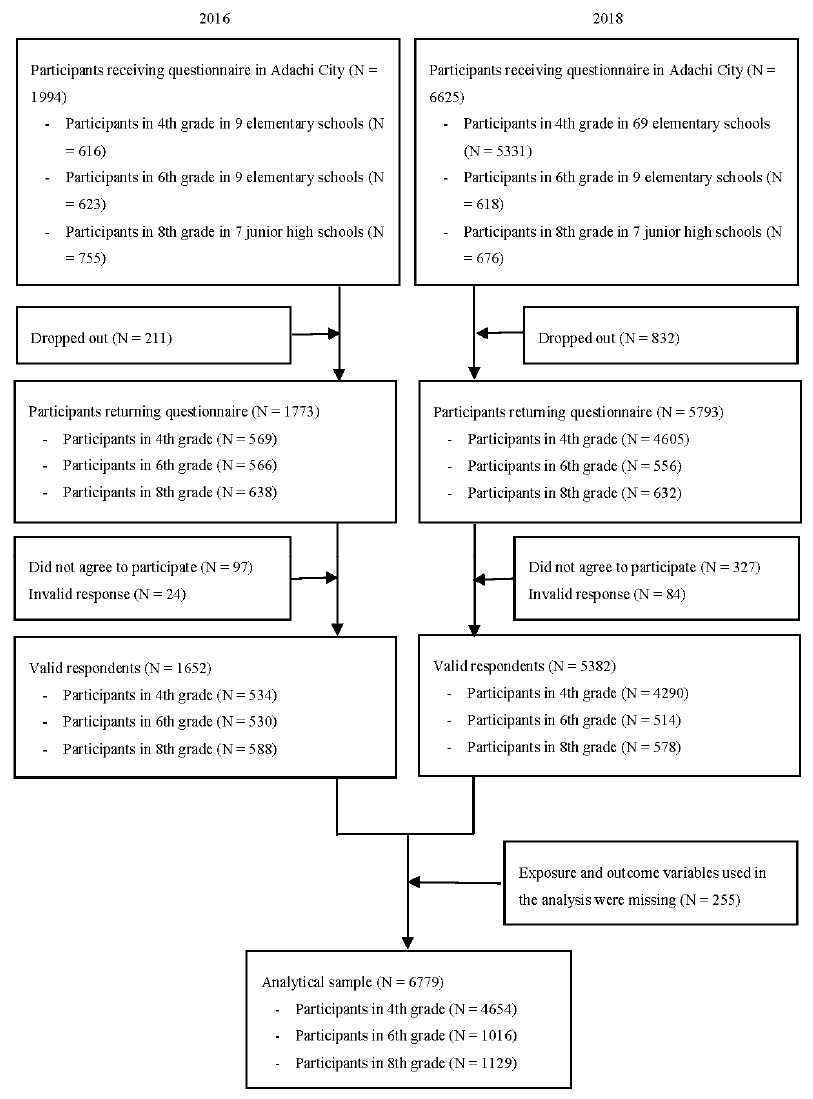
Figure 1. Participants flow chart.